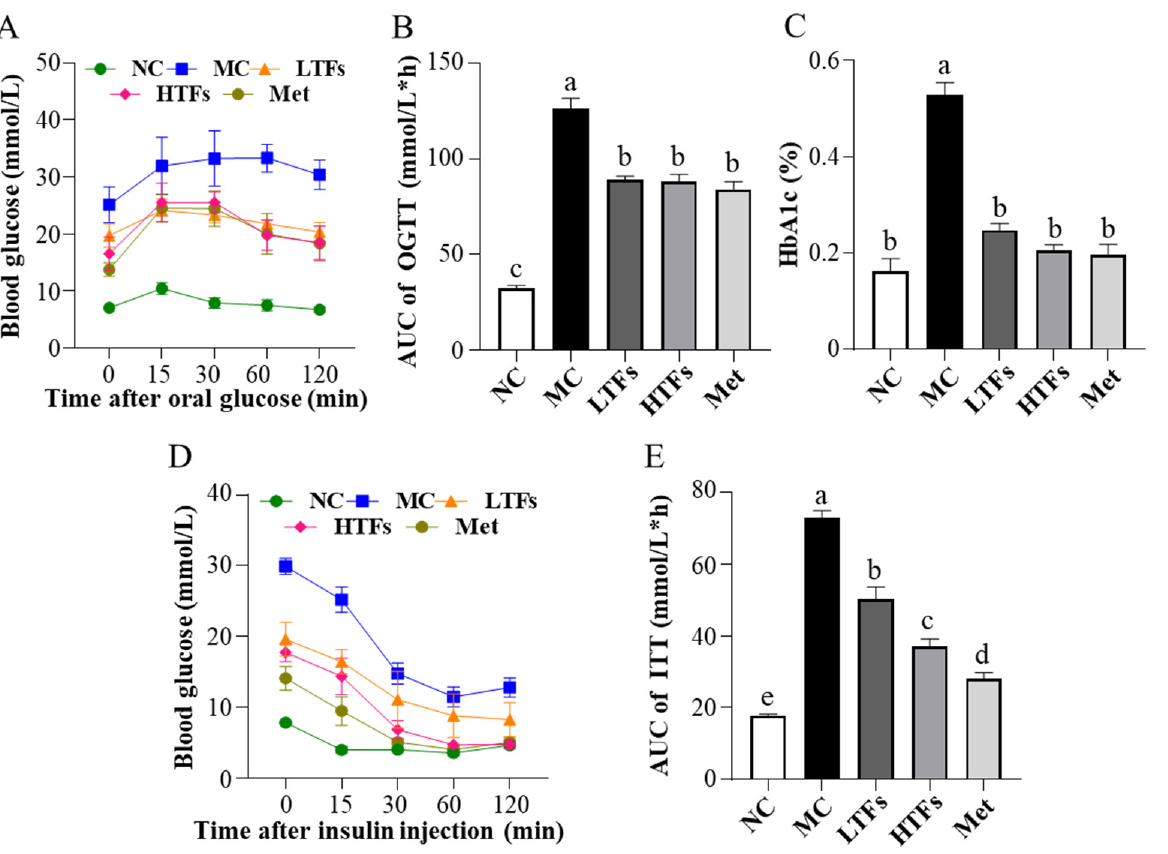
Figure 2. Effects of TFs on blood glucose and insulin homeostasis in T2DM mice. ( A ) Oral glucose tolerance test (OGTT) levels; ( B ) area under the curve (AUC) values of OGTT; ( C ) glycosylated hemoglobin type A1C (HbA1c) levels; ( D ) insulin tolerance test (ITT) levels; ( E ) area under the curve (AUC) values of ITT. NC: normal control; MC: diabetic model control; LTFs: low-dose TFs; HTFs: high-dose TFs; Met: metformin. Each value represents the mean ± SEM ( n = 6). Values with different letters (a–e) differ from each other significantly ( p <